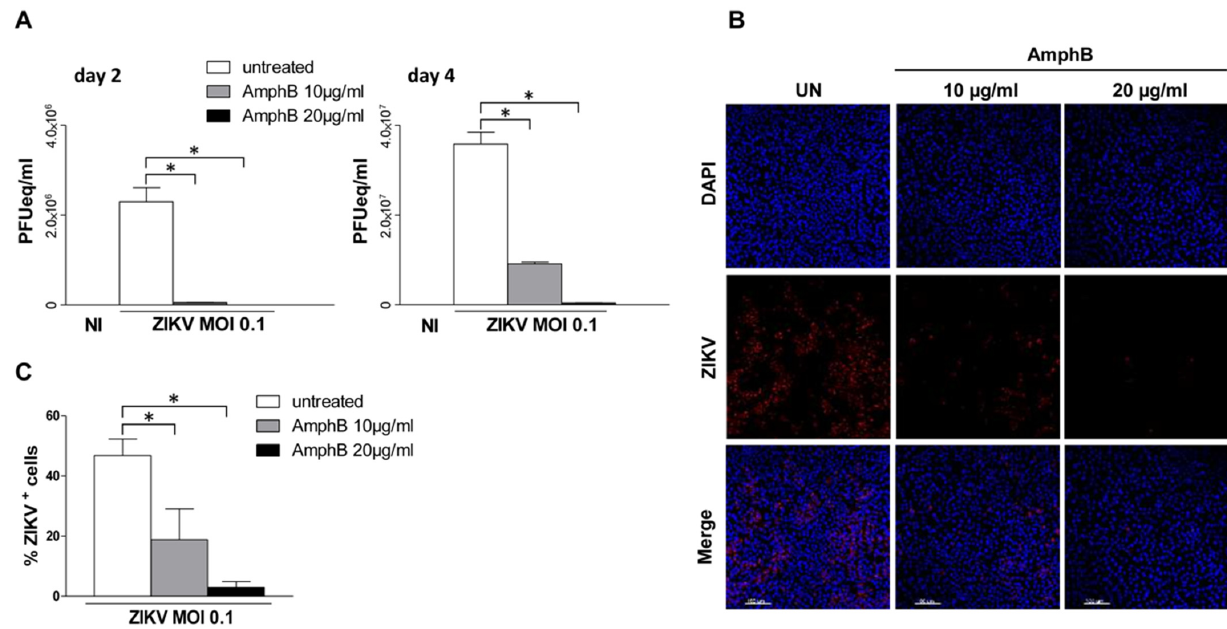
Figure 1. Disruption of lipid raft architecture by AmphB inhibits ZIKV replication and infection of Vero cells. Vero cells were left untreated or pre-treated with increasing doses of AmphB (10–20 µg/mL) for 30 min and adsorbed with ZIKV at MOI of 0.1 in medium +/ − AmphB for 1 h at 37 °C. NI: non-infected. ( A ) After 2 and 4 days of culture in fresh medium +/ − , AmphB viral titre was determined by qRT-PC and expressed as PFU equivalents/mL (PFUeq/mL). Drug treatment significantly inhibited viral replication in a dose-dependent manner. ( B ) Immunofluorescence analysis after 24 h of culture in fresh medium +/ − AmphB. Cells were fixed and stained with anti-pan-flavivirus antibody (ZIKV) followed by donkey anti-mouse AlexaFluo 647 antibody (red). Nuclei were stained with DAPI (blue). Scale bar is 100 µ m. Images are from one representative experiment out of three. ( C ) Percentage of infected cells was established for each sample using the Cell Counting tool of MetaMorph software. Data showed a dose-dependent inhibitory effect of the drug on cell infection that decreased from 47% to 19% at 10 µ g/mL and 20 µ g/mL, respectively. Results are expressed as mean ± standard deviation (SD) of three independent experiments performed. Significance was determined by GraphPad Prism using the nonparametric Mann–Whitney U test. * p value < 0.05 was considered statistically